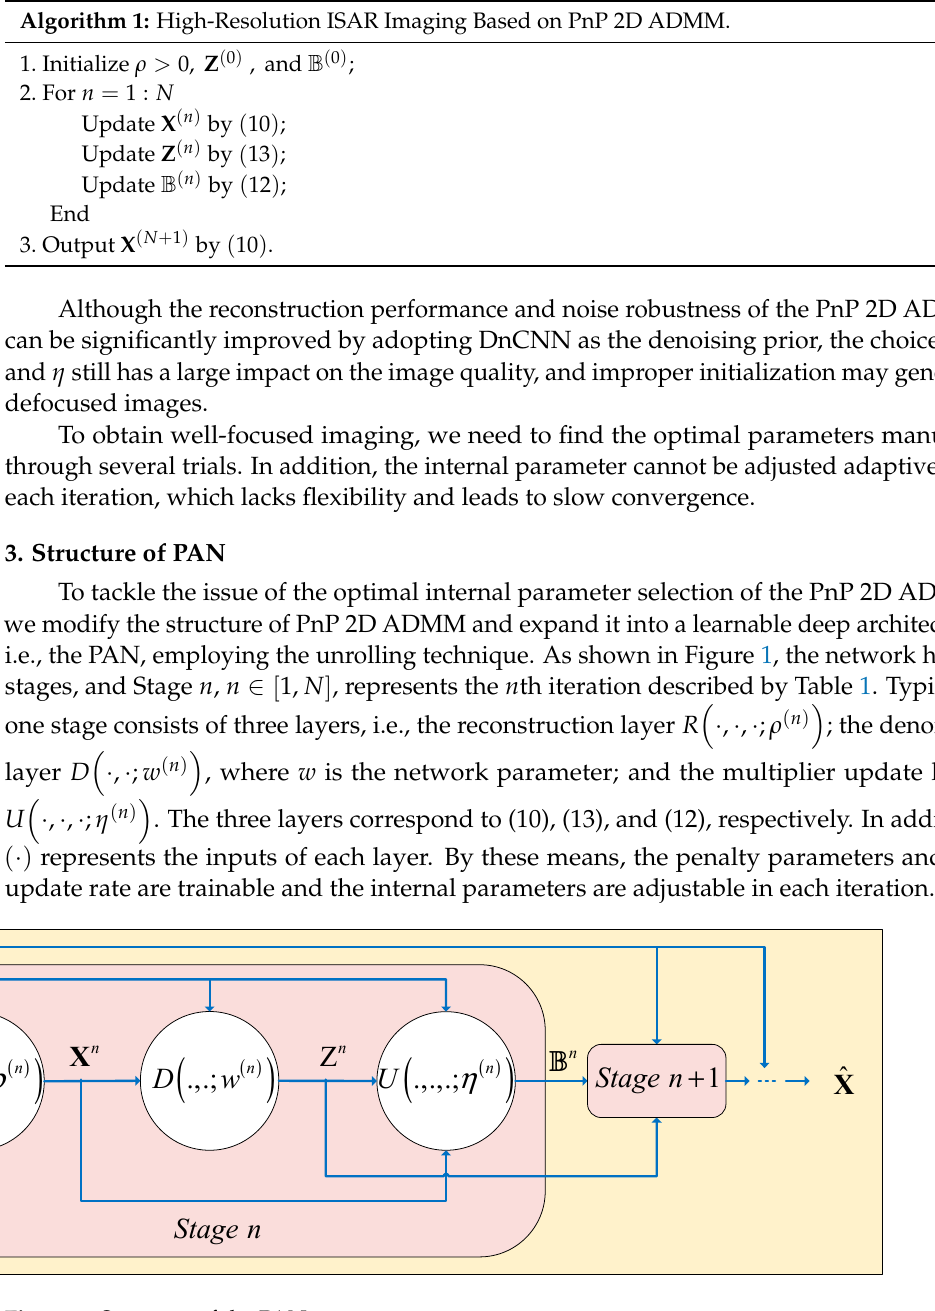
Algorithm 1: High-Resolution ISAR Imaging Based on PnP 2D ADMM.